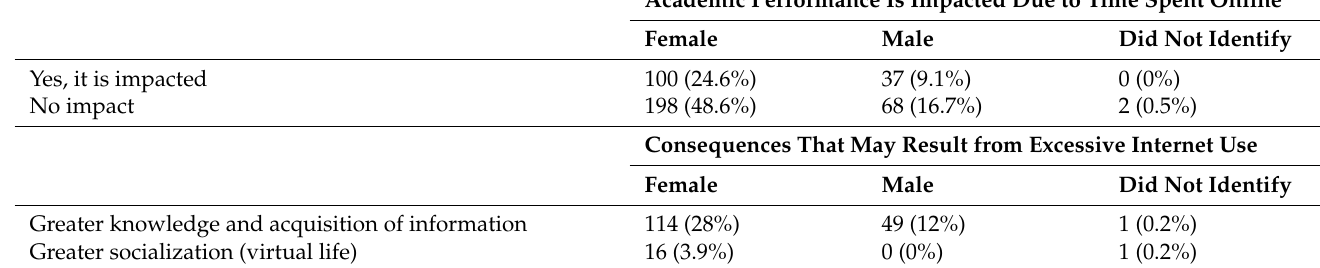
Table 7. Impact on academic performance and consequences of excessive Internet use by gender. Academic Performance Is Impacted Due to Time Spent